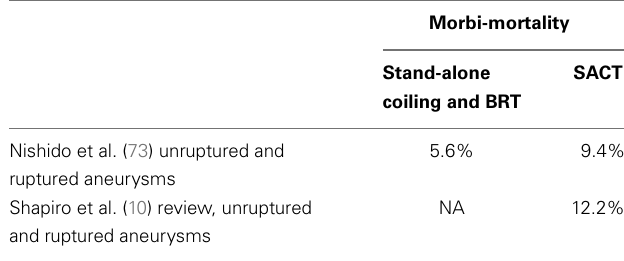
Table 2 | Stent-assisted coiling technique complications with clinical